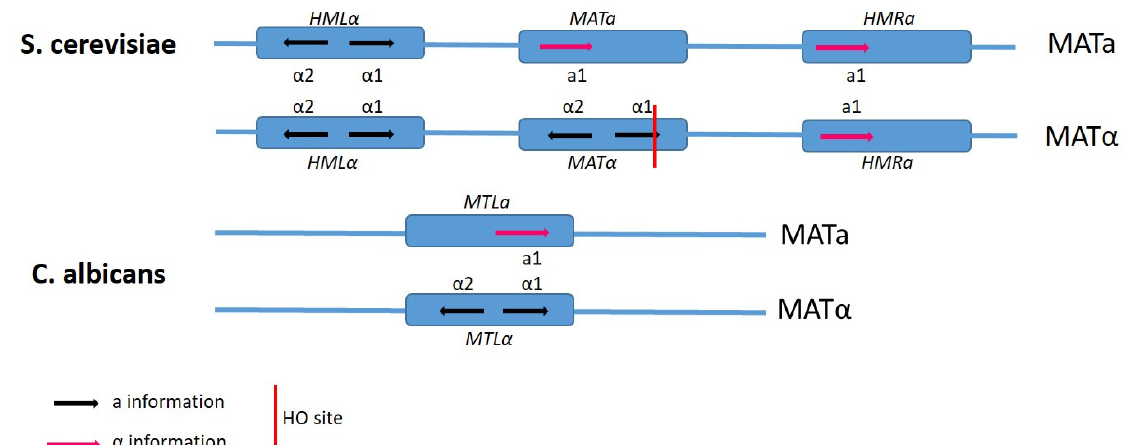
Figure 2. A schematic representation of the mating-type loci in S. cerevisiae and C. albicans. S. cerevisiae has three mating-type loci; HML α , MAT a or MAT α , and HMR α compared to one MLT in C. albicans . The MAT and MTL regions determine the mating type. In S. cerevisiae , the mating-type loci are all found on chromosome 3 and chromosome 5 in C. albicans . There is also no HO endonuclease site in C. albicans.